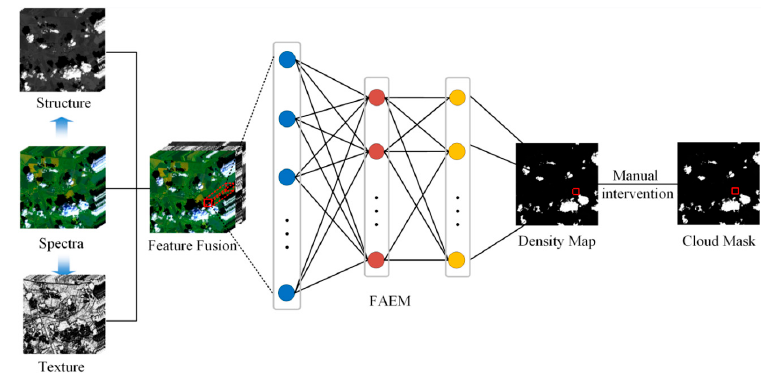
Figure 2. The framework of proposed method.